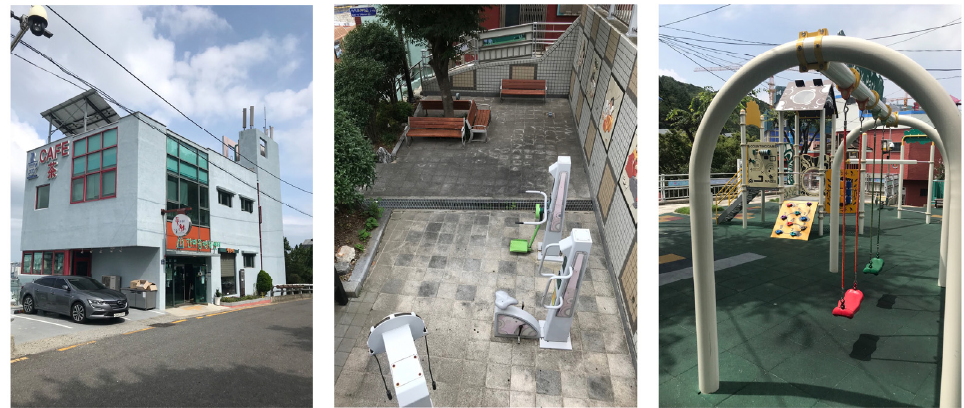
Figure 7. Happy Village Community Centre and small community spaces.